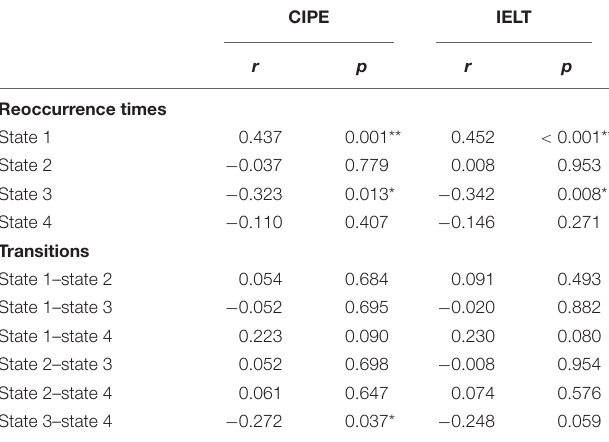
TABLE 3 | Correlations between dynamic functional connectivity metrics and clinical variables.